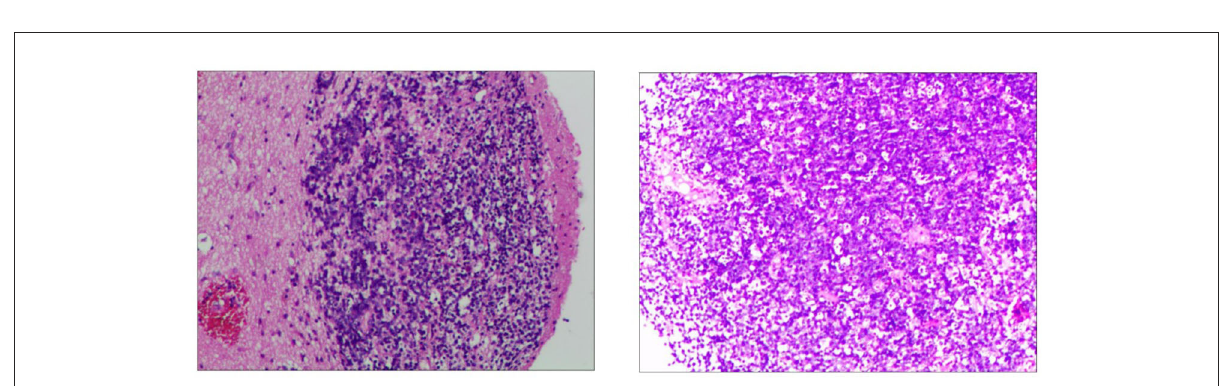
FIGURE3 Immunohistochemistry of the third ventricular lesion reveals: CD10 ( + ), CD20 ( + ), MUM-1 ( + ), Bcl-2 ( + , 90%), Bcl-6 ( + ), C-myc ( + , 10%), Ki-67 ( + , 80%), ALK (–), CD3 (–), CD30 (–), cyclin D1 (–), EBER (–), and P53 (wild-type expression).